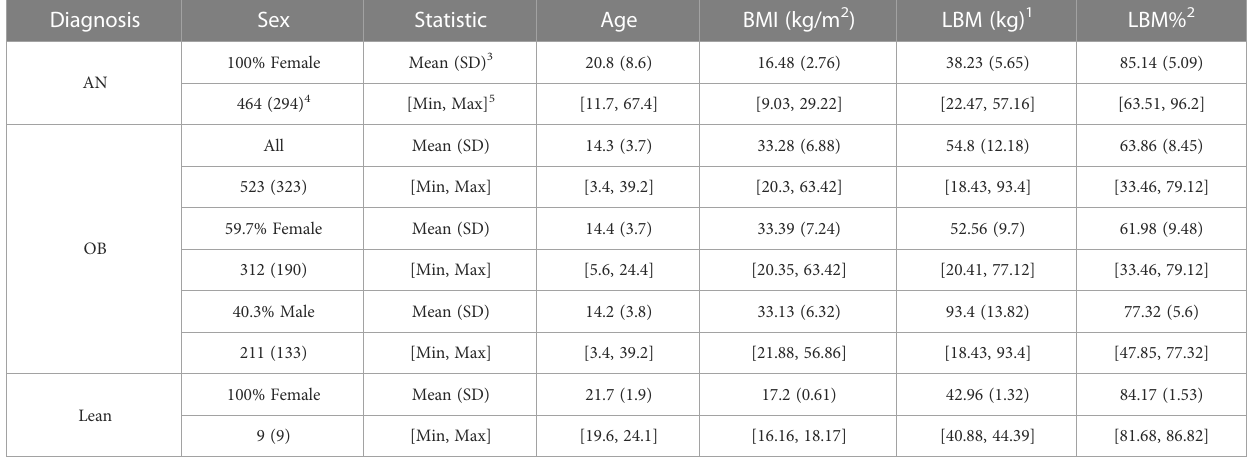
TABLE 1 Phenotypes of the study groups.